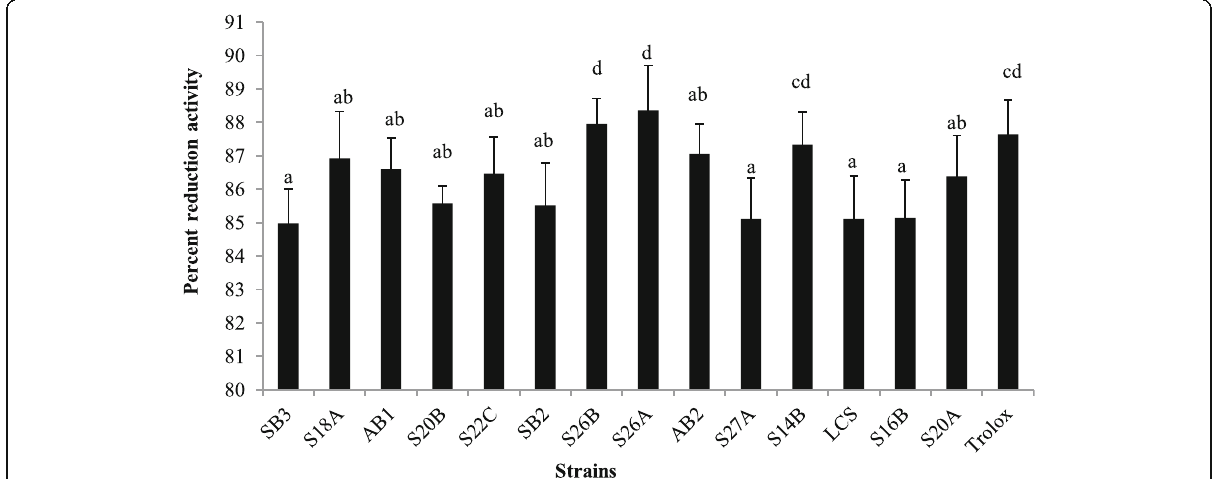
Fig. 6 Antioxidant activity of Enterococcus cell-free supernatant by ABTS free radical scavenging assay. Columns with different letters are significantly different p <